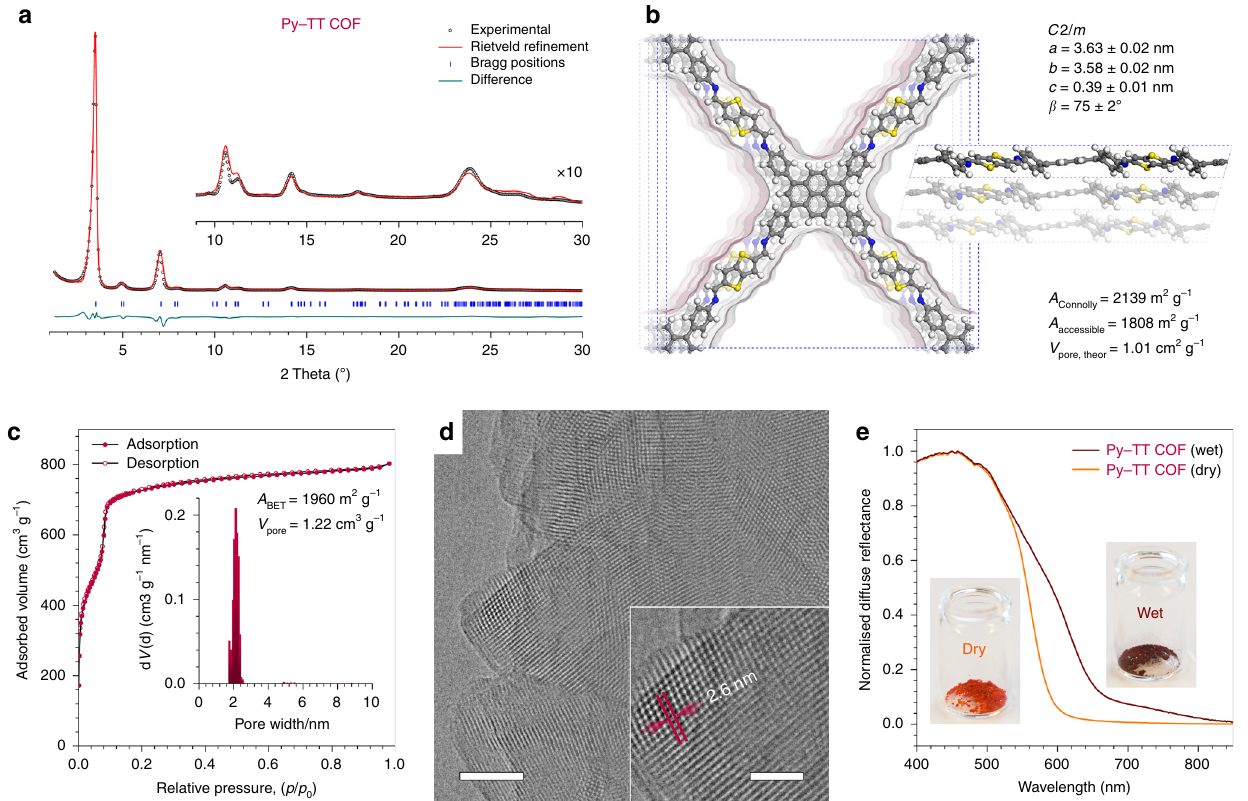
Fig. 2 Structure analysis and solvatochromism of the Py – TT COF bulk powder. a Experimental PXRD pattern (black dots) of the Py – TT COF powder. Rietveld re fi nement (red line) using the structure model displayed in b provides a very good fi t to the experimental data with only minimal differences between the experimental and the re fi ned patterns (green line). R wp = 4.9%, R p = 10.5%. Bragg positions are indicated by blue ticks. Inset, magni fi ed view of the 2 θ > 9° region. b Top view (left) and side view (right) of the corresponding unit cell reveal the pseudo-quadratic, offset-stacked structure that is typical for pyrene-based COFs. Crystallographic data are available as Supplementary Data 1. The structure has a Connolly surface of 2139 m 2 g − 1 , an accessible surface area of 1808 m 2 g − 1 and a pore volume of 1.01 cm 3 g − 1 . c Nitrogen sorption isotherm of the Py – TT COF recorded at 77 K. Inset, QSDFT calculation using an equilibrium model yields a very narrow pore size distribution with a maximum at 2.1 nm. d High-resolution TEM image showing the large crystal domains of the Py – TT COF. Scale bar: 40 nm. Inset, magni fi ed view onto a COF crystallite visualizing the pseudo-quadratic arrangement of the COF pores with a periodicity of 2.6 ± 0.1 nm. Scale bar: 20 nm. e Diffuse re fl ectance spectra of the dry (orange) and water vapour-saturated (brown) Py – TT COF powder showing a strong solvatochromic